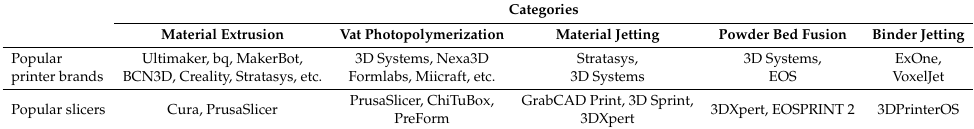
Table 7. Printer brands with popular slicer